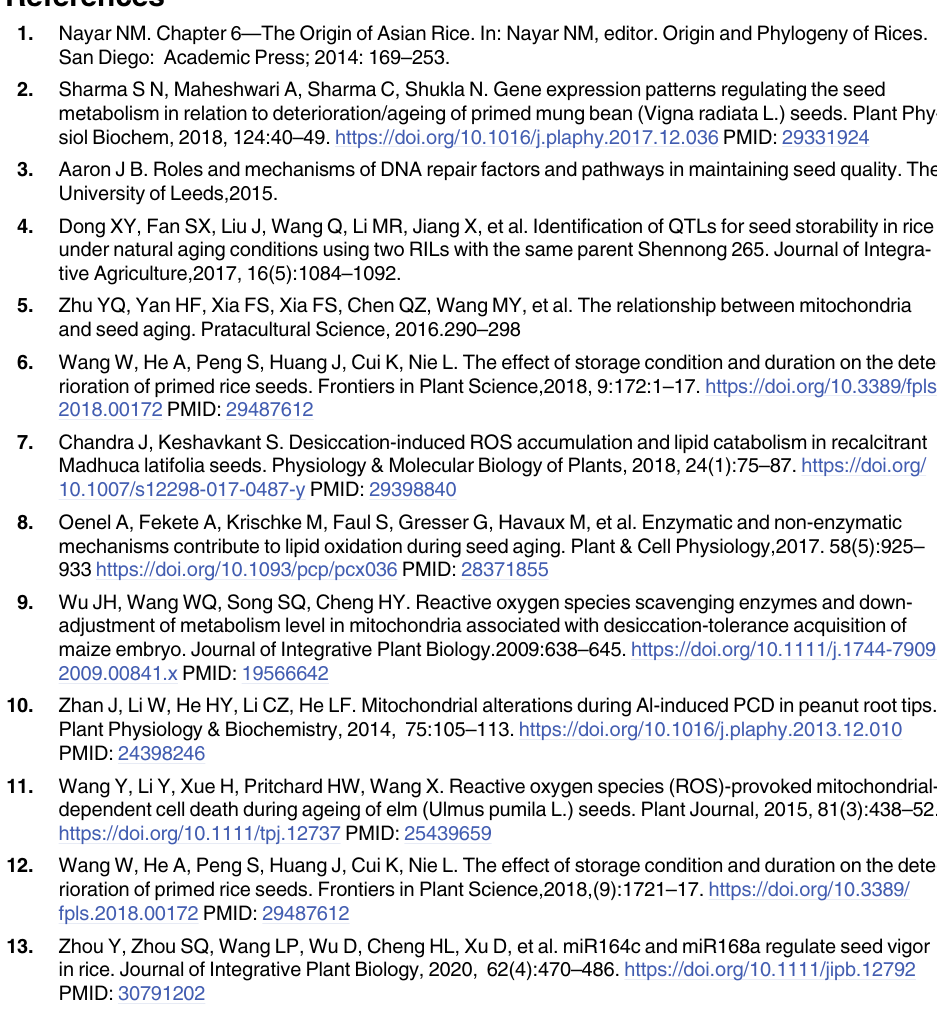
S2 Table. Precursor of converted miRNA and novel miRNA. S3 Table. Degradome